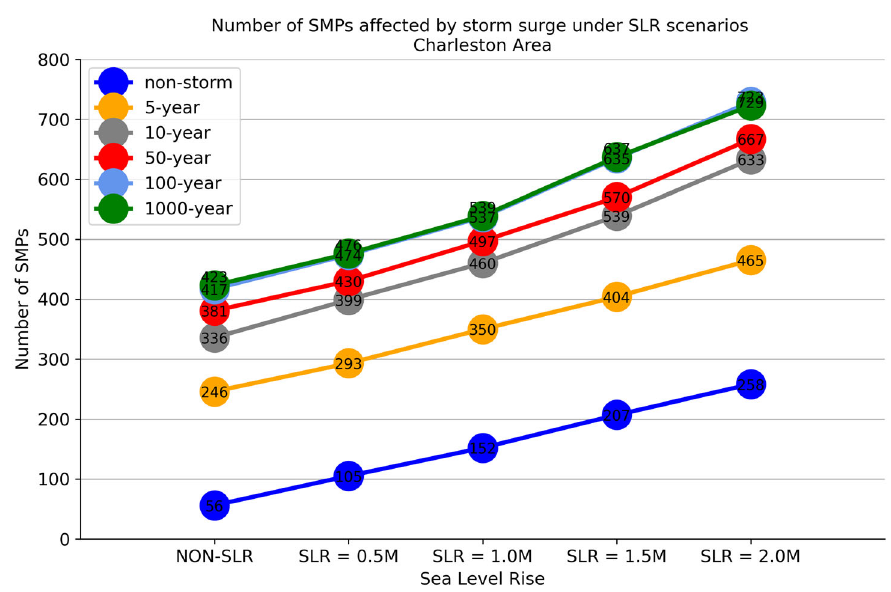
Figure 7. The number of SMPs in Charleston Harbor that are at risk of storm surge heights with 0 ‐ year (non ‐ storm), 5 ‐ year, 10 ‐ year, 50 ‐ year, 100 ‐ year, and 1000 ‐ year return periods under